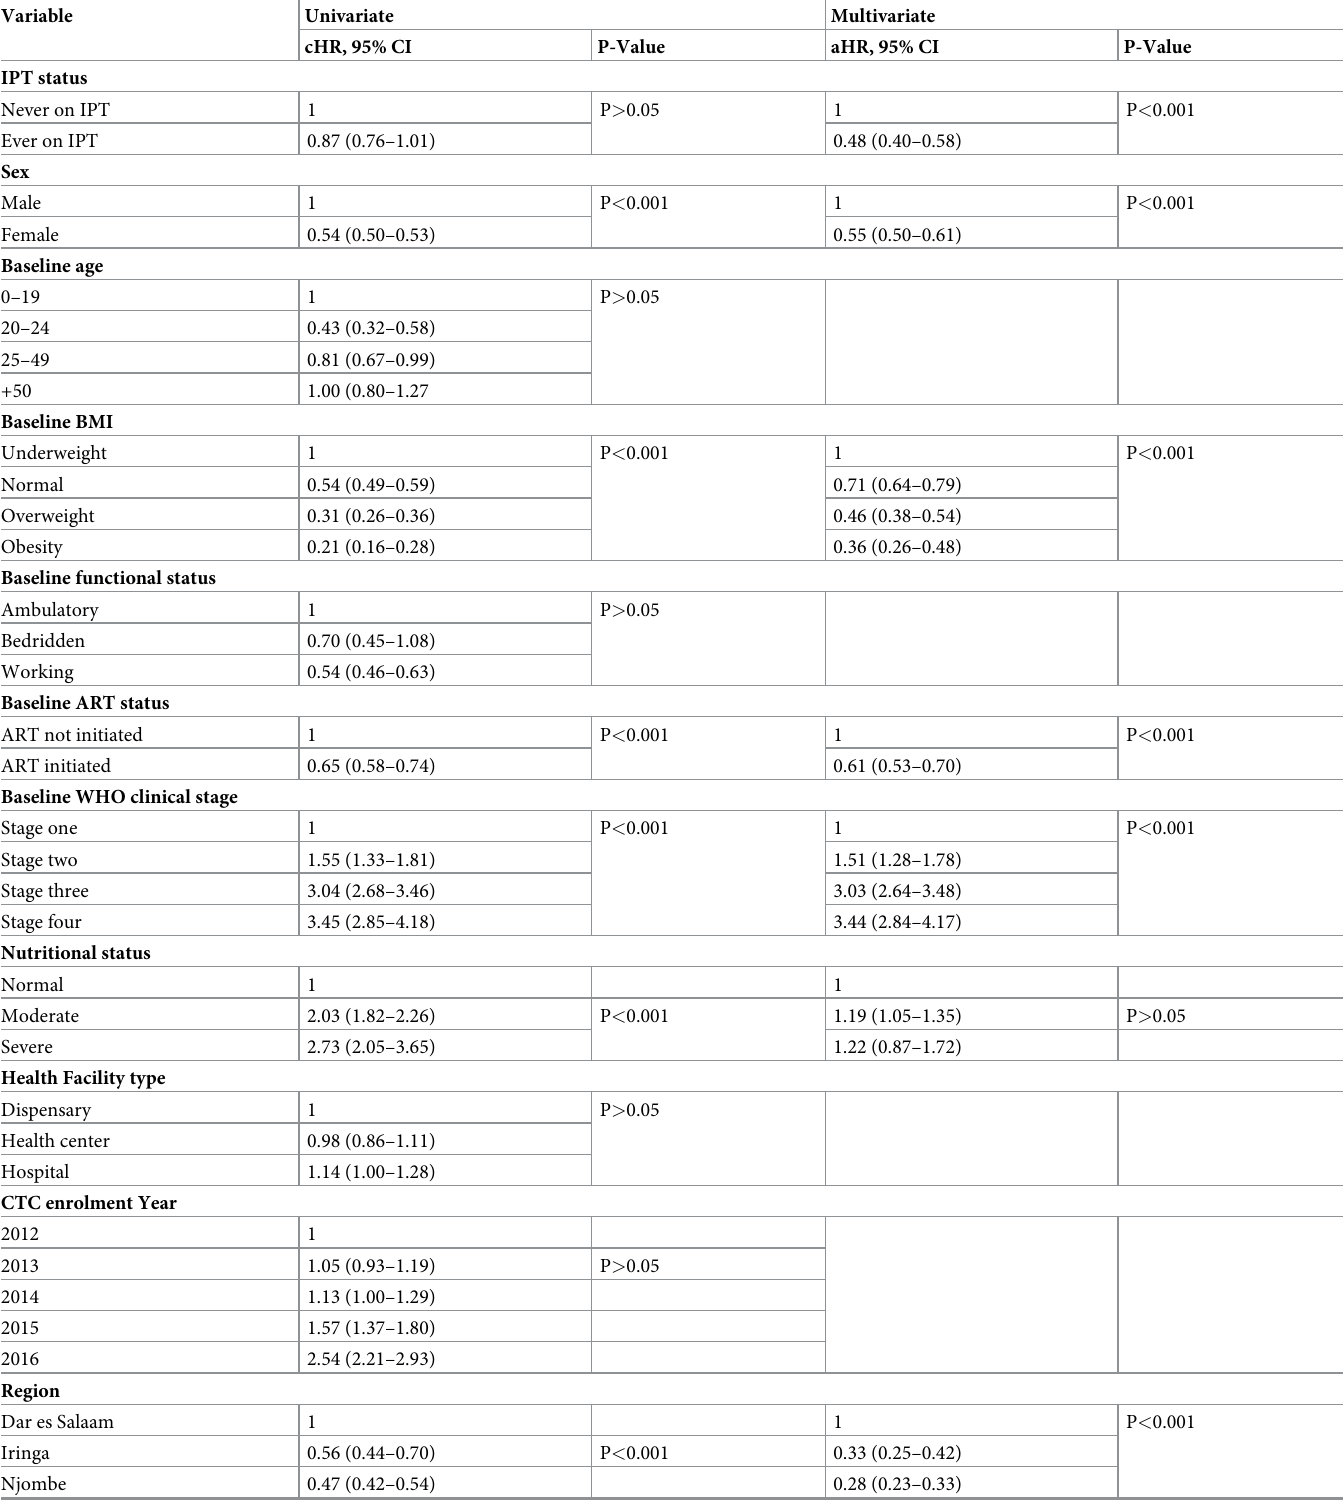
Table 4. Risk factors for TB disease using weighted